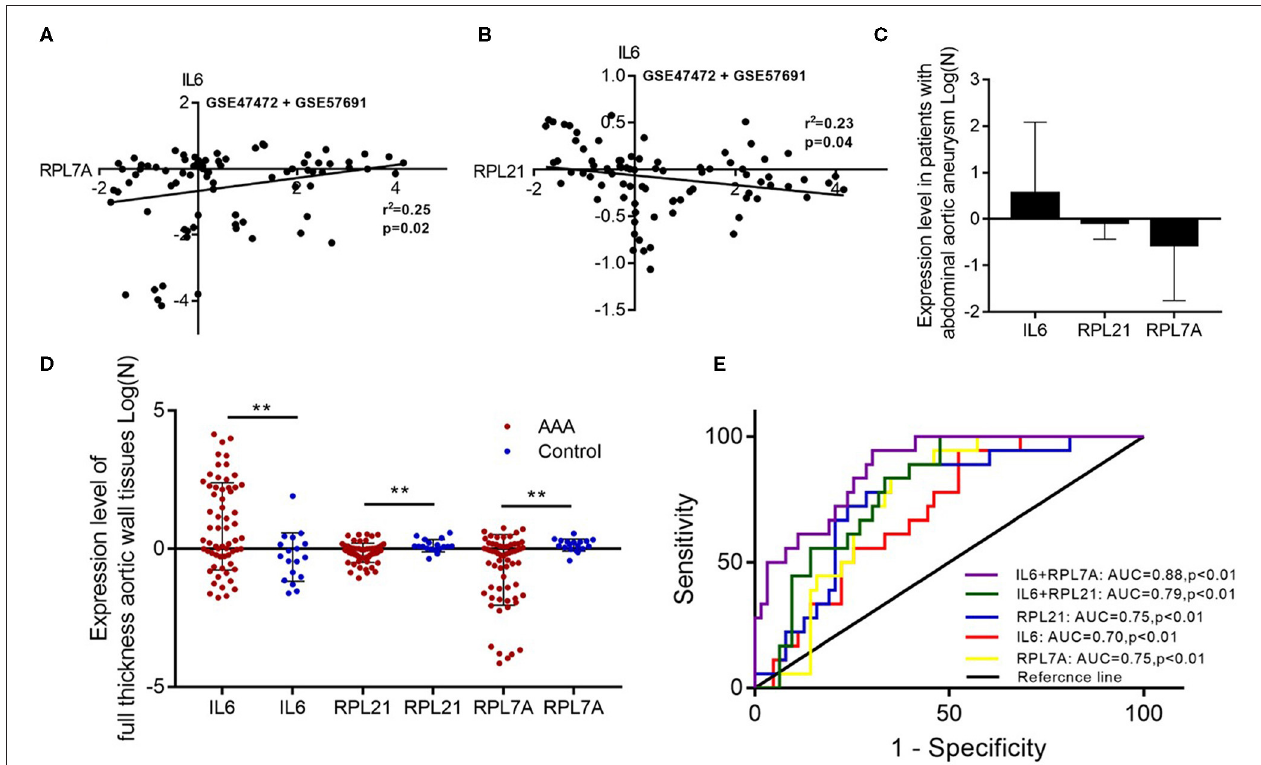
FIGURE 6 | The relationship and their diagnostic value between differentially expressed genes (DEGs) in the abdominal aortic aneurysm (AAA). (A) The expression levels of IL6 and RPL7A showed the positive correlation in the AAA. (B) The expression levels of IL6 and RPL21 showed the negative correlation in the AAA. (C) The expression of IL6 was upregulated, and RPL21 RPL7A were downregulated in the AAA. (D) The expression levels of the key DEGs between the AAA and normal group in the GSE47472 and GSE57691 datasets. ** P < 0.01. (E) Receiver operating characteristic analysis of the sensitivity and specificity of the predictive value of the combined IL6 and RPL21; IL6 and RPL7A expression model, IL6 expression model, RPL7A expression model, and RPL21 expression